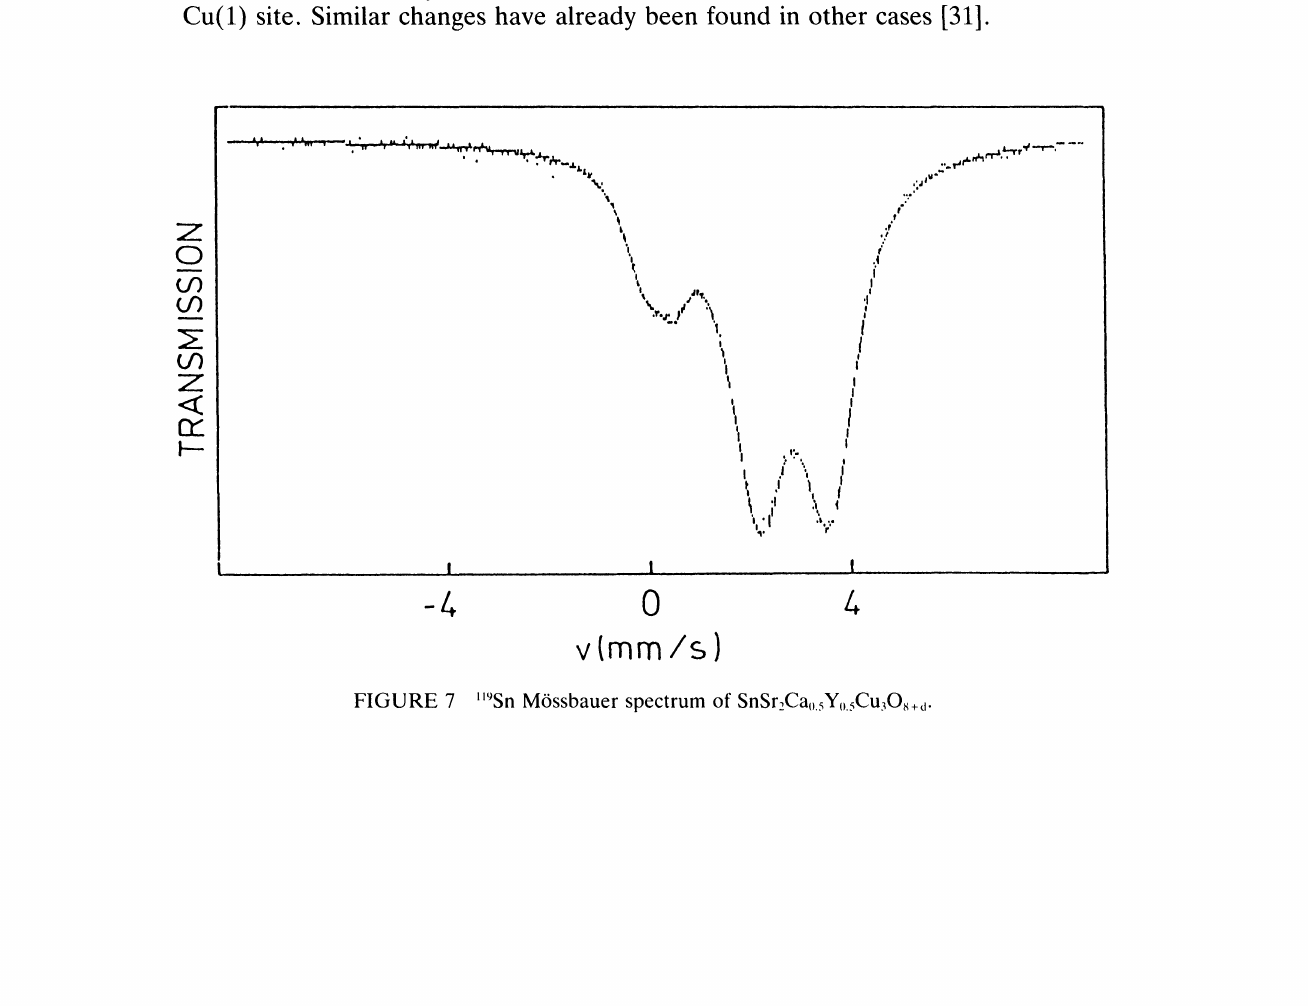
FIGURE 7 gSn M6ssbauer spectrum of